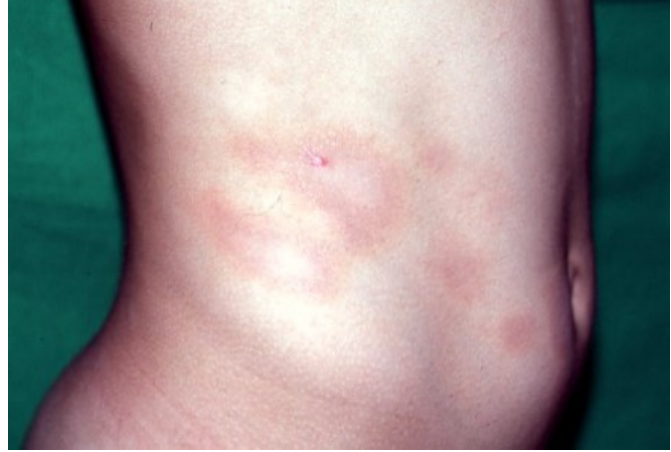
Figure 1. Early lesions consist of erythematous macules and vaguely annular patches with a slightly raised border and irregular zones of central clearing on the groin and flank.